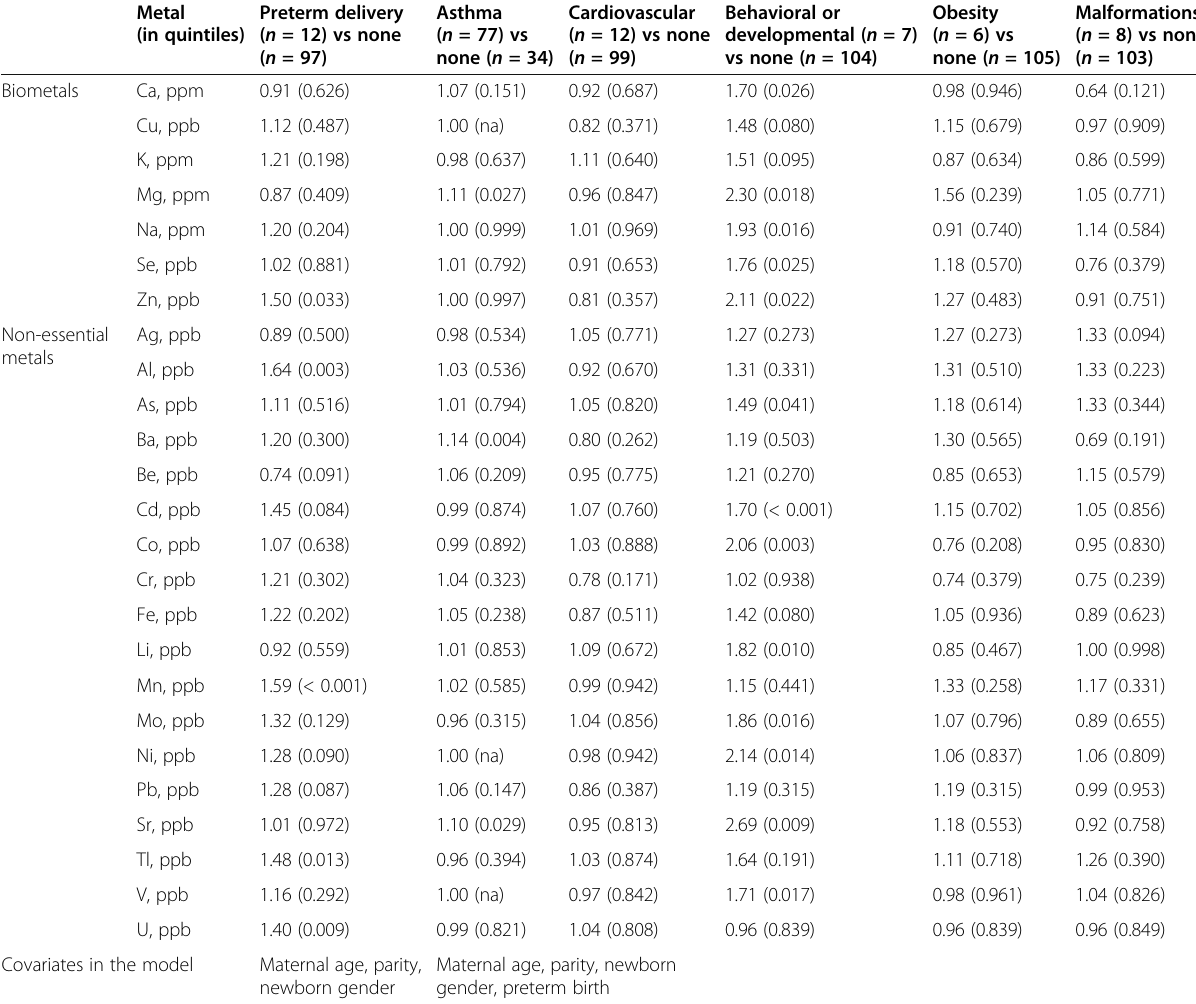
Table 3 Association between internal dose of metals in quintiles and presence of a clinical outcome at birth, adjusted to maternal and newborn clinical background and SGA 1 , 2 Metal Preterm delivery (in quintiles) ( n = 12) vs